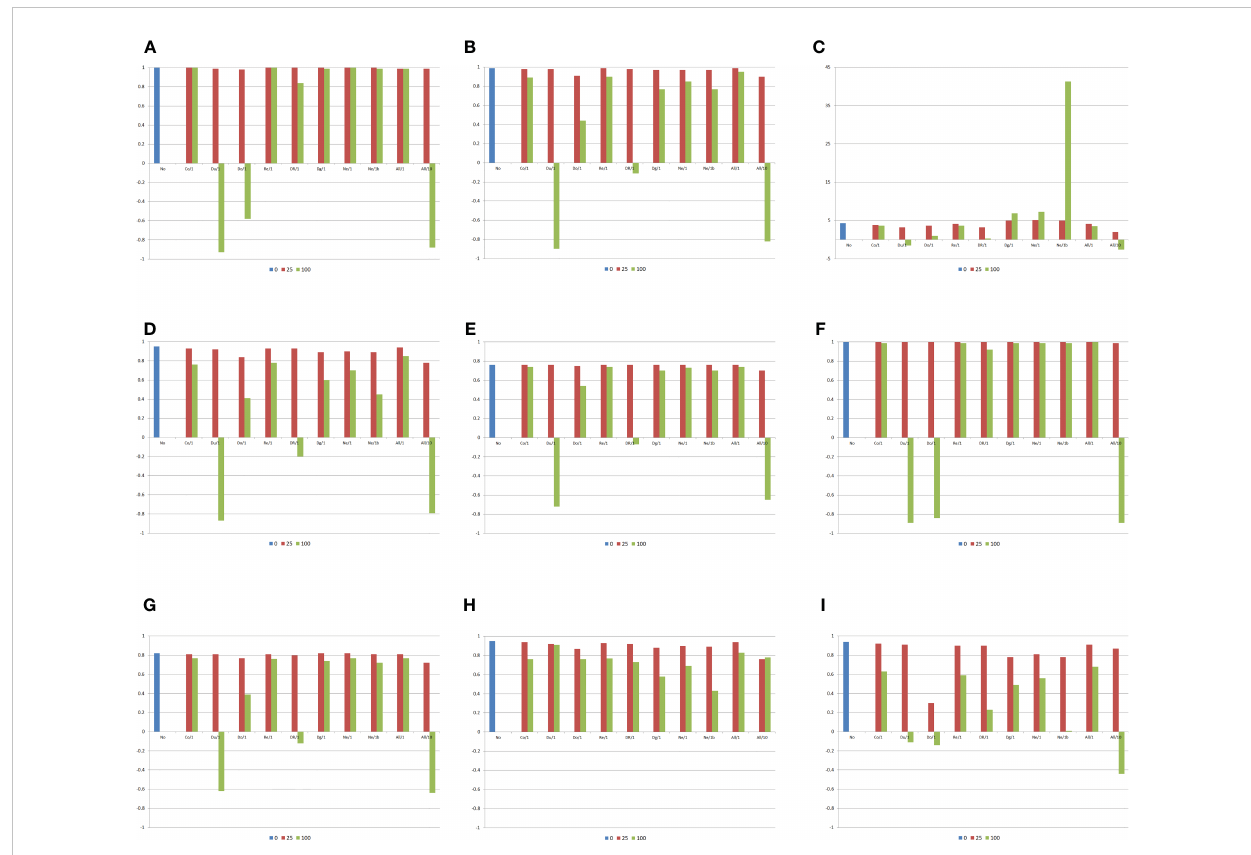
FIGURE 2 Correlations between the average frequency for the genes that increase the trait expression, the average absolute allelic frequency differences between populations, the absolute average allelic frequency differences between a population and the other diallel parents, or the average frequency for the genes that increase the trait expression minus 0.5 and the genetic components of the heterosis and combining ability analyses, and average heterosis (g/plant), assuming no epistasis (No), seven types of digenic epistasis and an admixture of these types (All), 25% and 100% of epistatic genes, and ratios V(I)/(V(A) + V(D)) of 1 and 10. (A) v * j , (B) H *